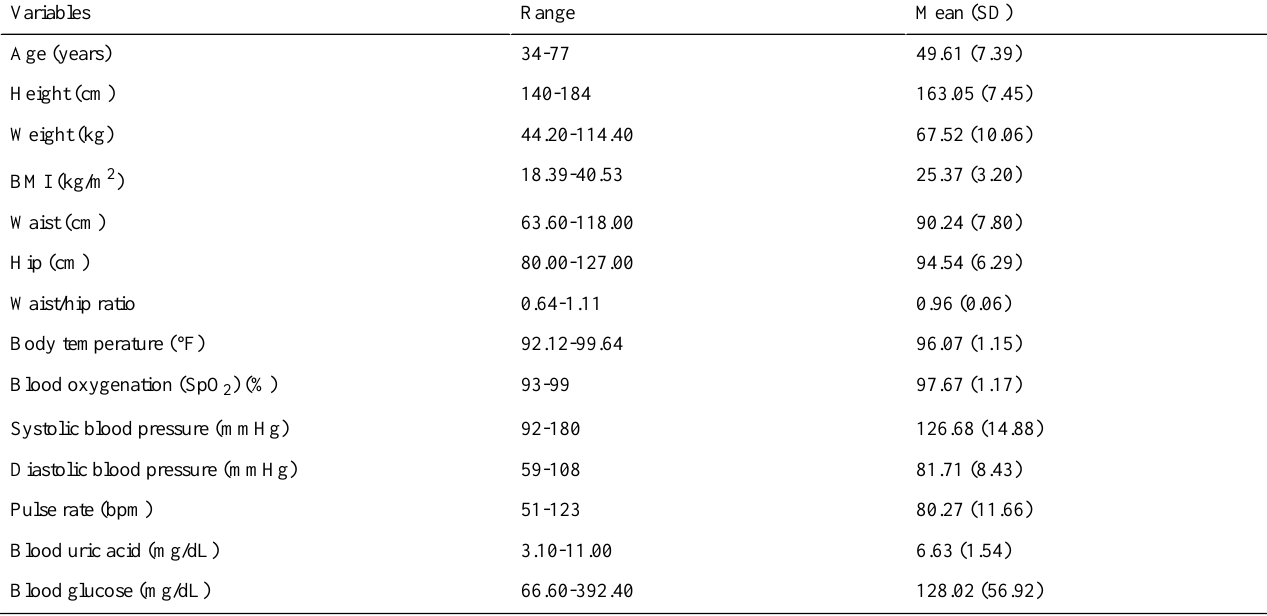
Table 1. Summary statistics of the selected continuous predictors